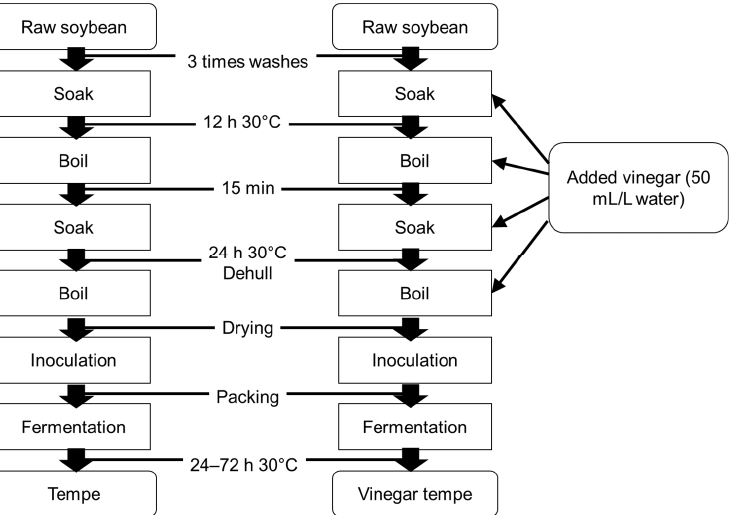
Figure 1. Workflow of production of control and vinegar ‐ treated tempe using Rumah Tempe Indo ‐ nesia (RTI) method.